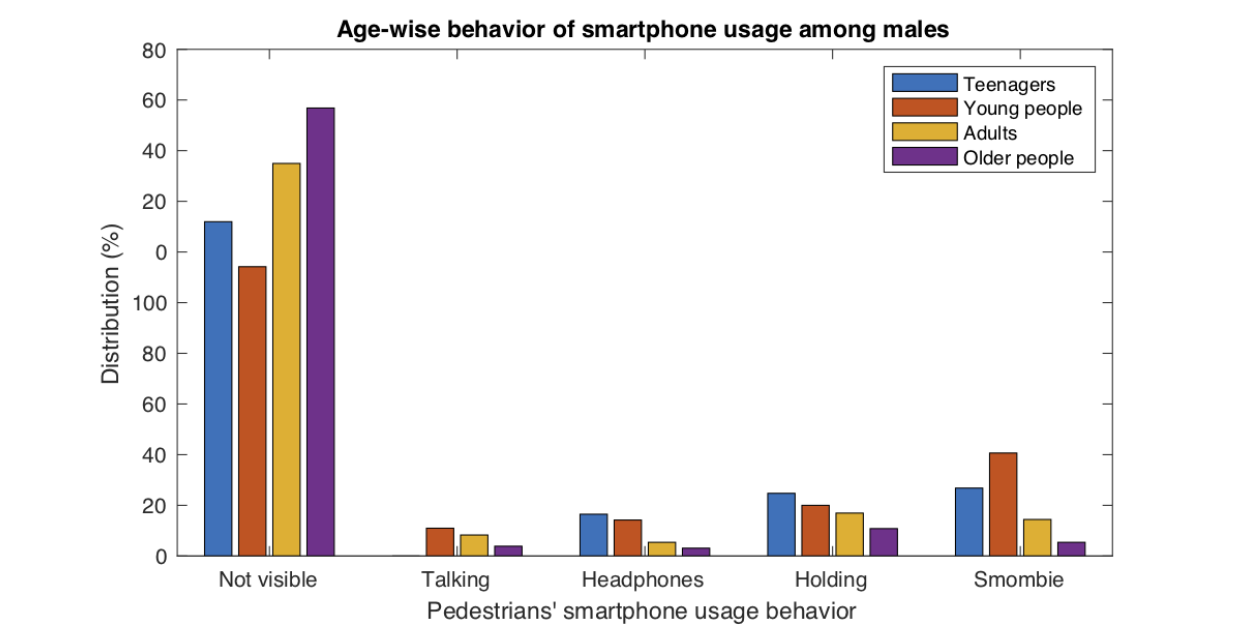
Figure 8. Smartphone usage behavior of males across different age